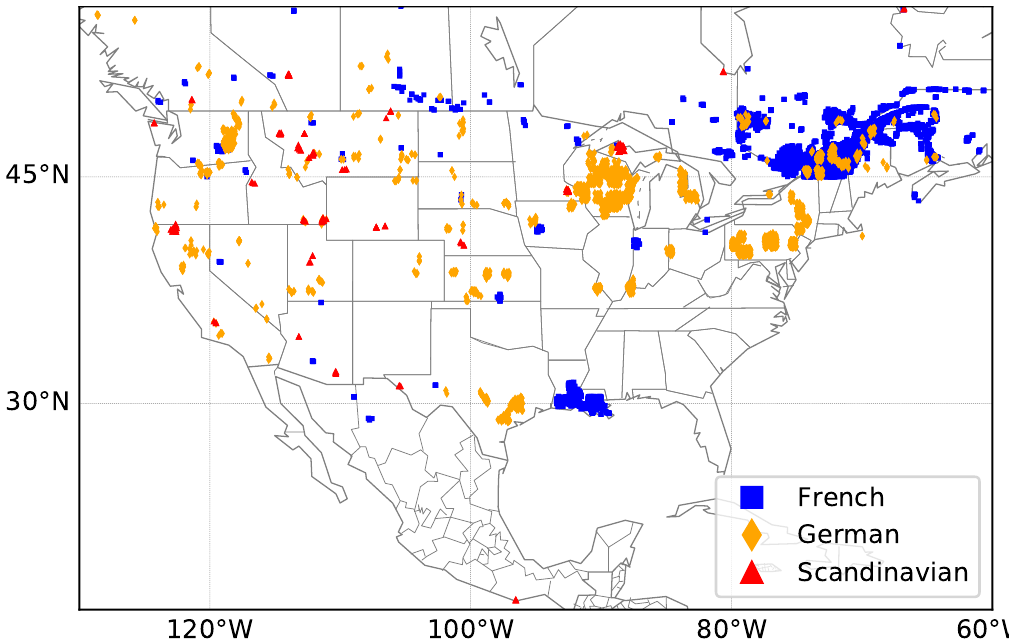
Figure 7. Clusters of European streets based on closely located streets whose names are classified as originating from the same European